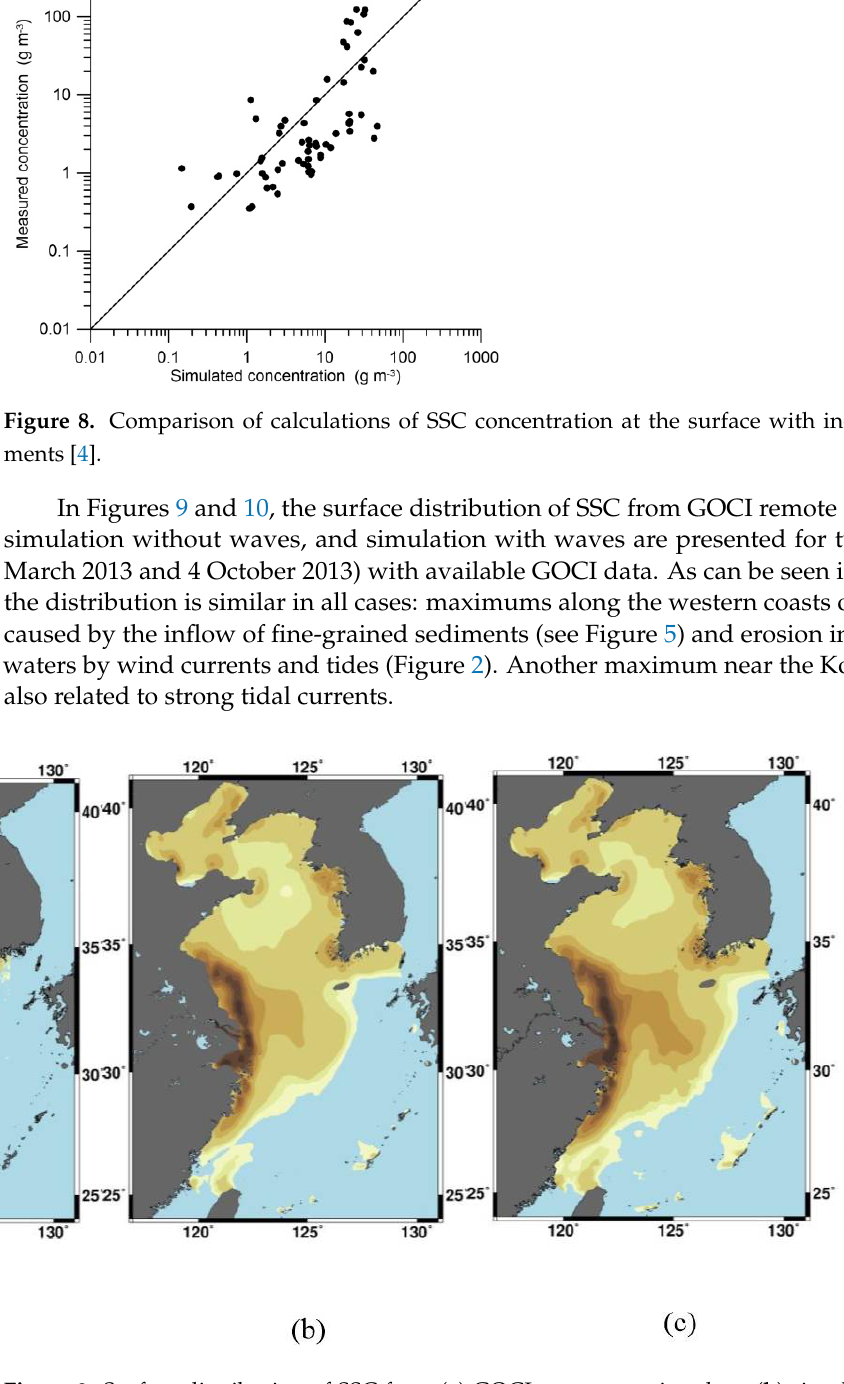
Figure 9. Surface distribution of SSC from ( a ) GOCI remote sensing data; ( b ) simulation without waves; ( c ) simulation with waves for 21 March